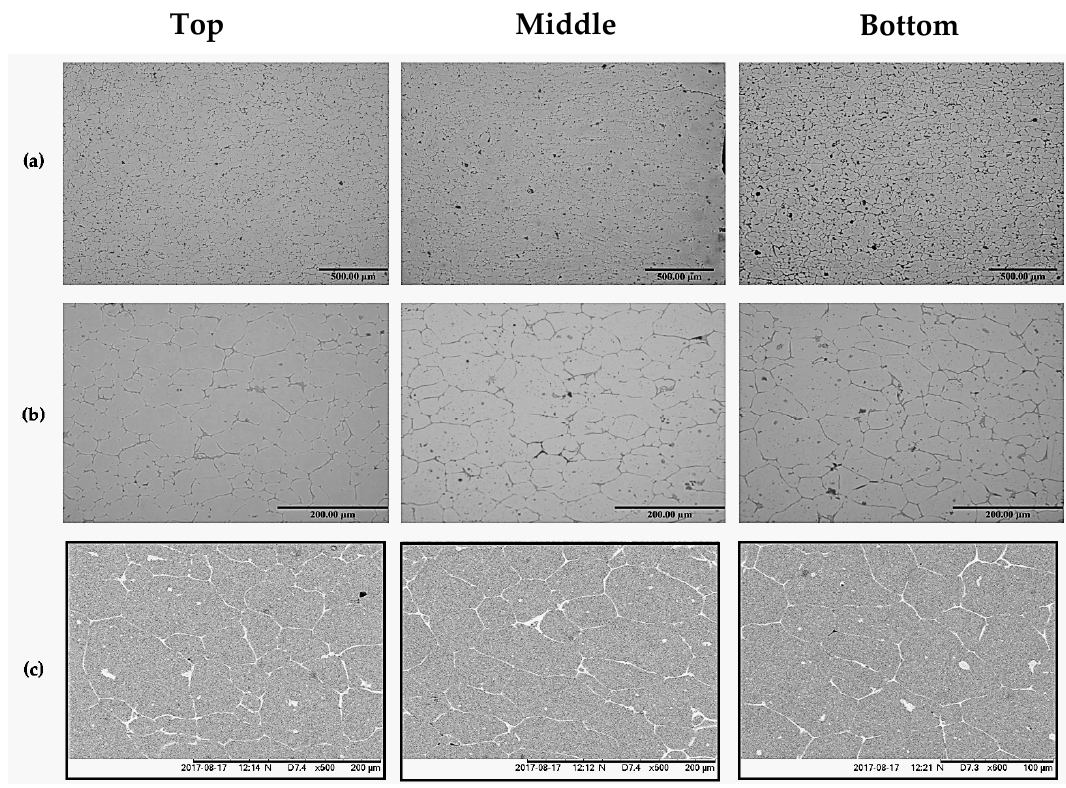
Figure 2. Optical microscopy images of heat-treated specimens illustrating the microstructure of the material ( a ) top, middle and bottom of the welding line; ( b ) higher magnification of same images of material in top, middle and bottom of the welding line (as described in Figure 4) and ( c ) SEM images of the specimens taken from similar regions.